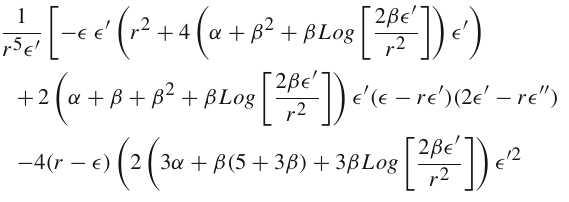
< 0, for shape function (cid:6)( r ) = Fig. 3 Region plot F = df dR function we get F (cid:5) = 0 for β < 0. So, the positivity of NEC totally > depends on the F = df dR